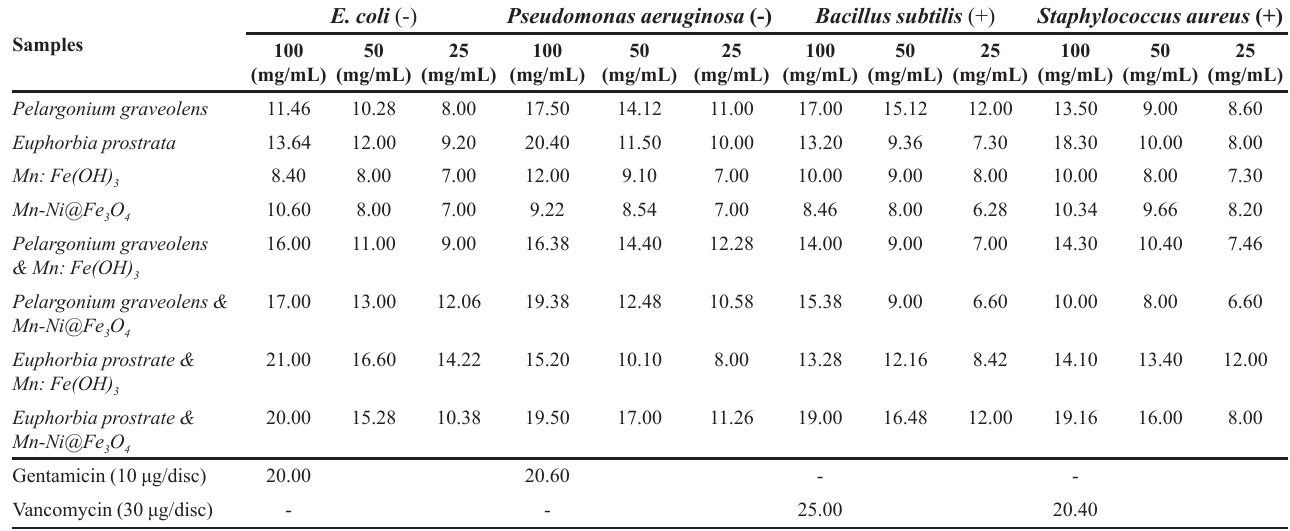
TABLE III - Anti bacterial activity as diameter of zone of inhibition ∗ (mm) around the constructed and standard discs. ∗∗ All data are the mean of three measurements